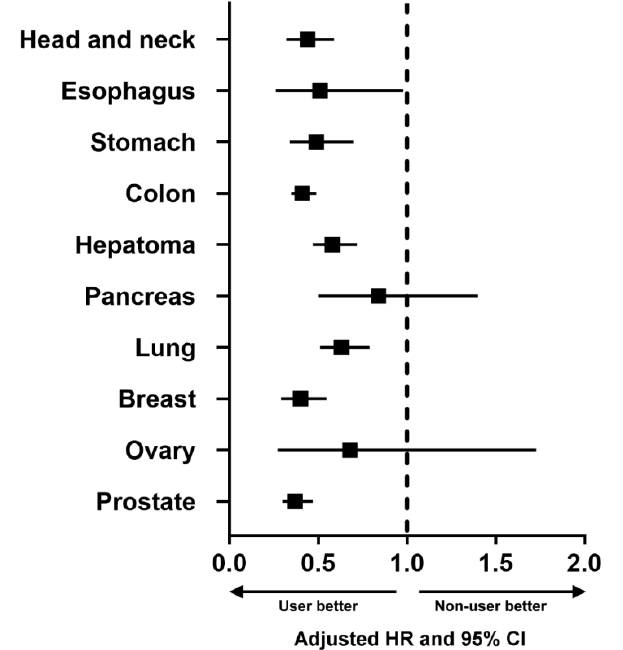
Figure 3. Forest plot showing the adjusted hazard ratio (HR) and 95% confidence interval (CI) of the 10 most common cancers in Taiwan, comparing aspirin users with aspirin 10 most common cancers in Taiwan, comparing aspirin users with aspirin nonusers.